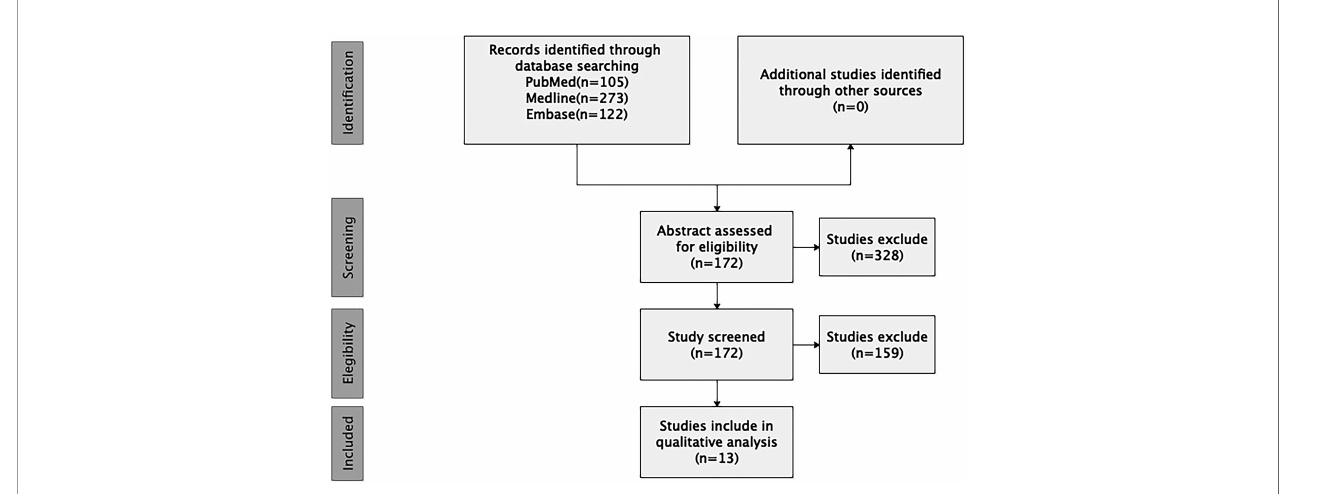
FIGURE 1 | PRISMA fl ow